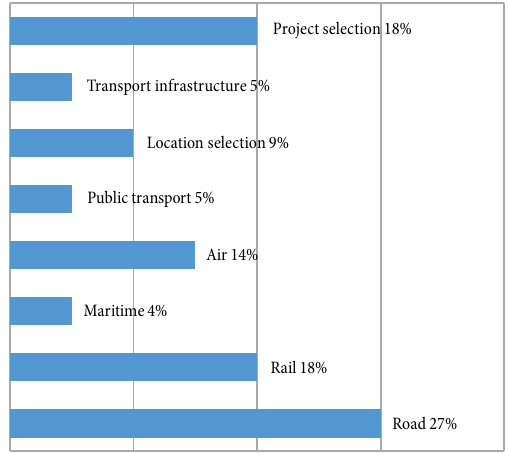
Fig. 1. Frequency with which the AHP method has been applied to different types of transport projects in the